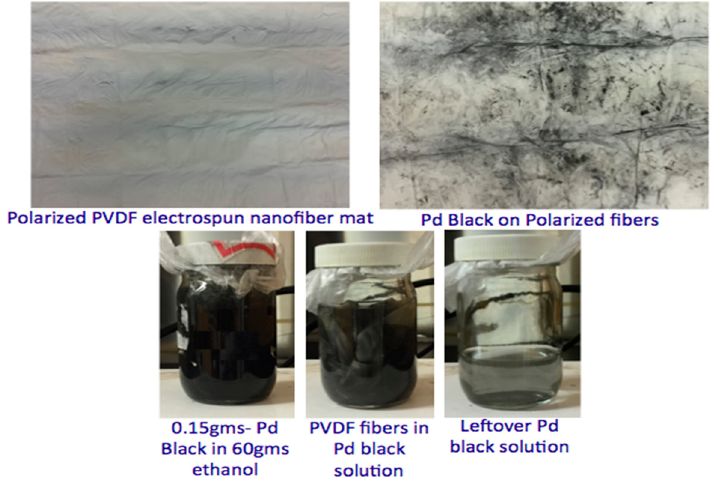
Figure 4. Preparation of electrospun polarized palladium (Pd)/PVDF.